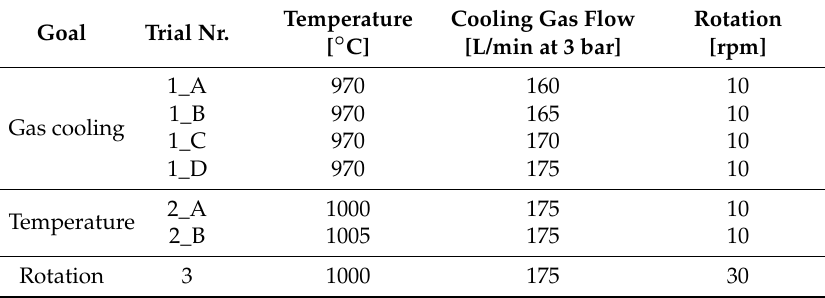
Table 2. Experimental parameters used in the germanium crystallization. Goal Trial